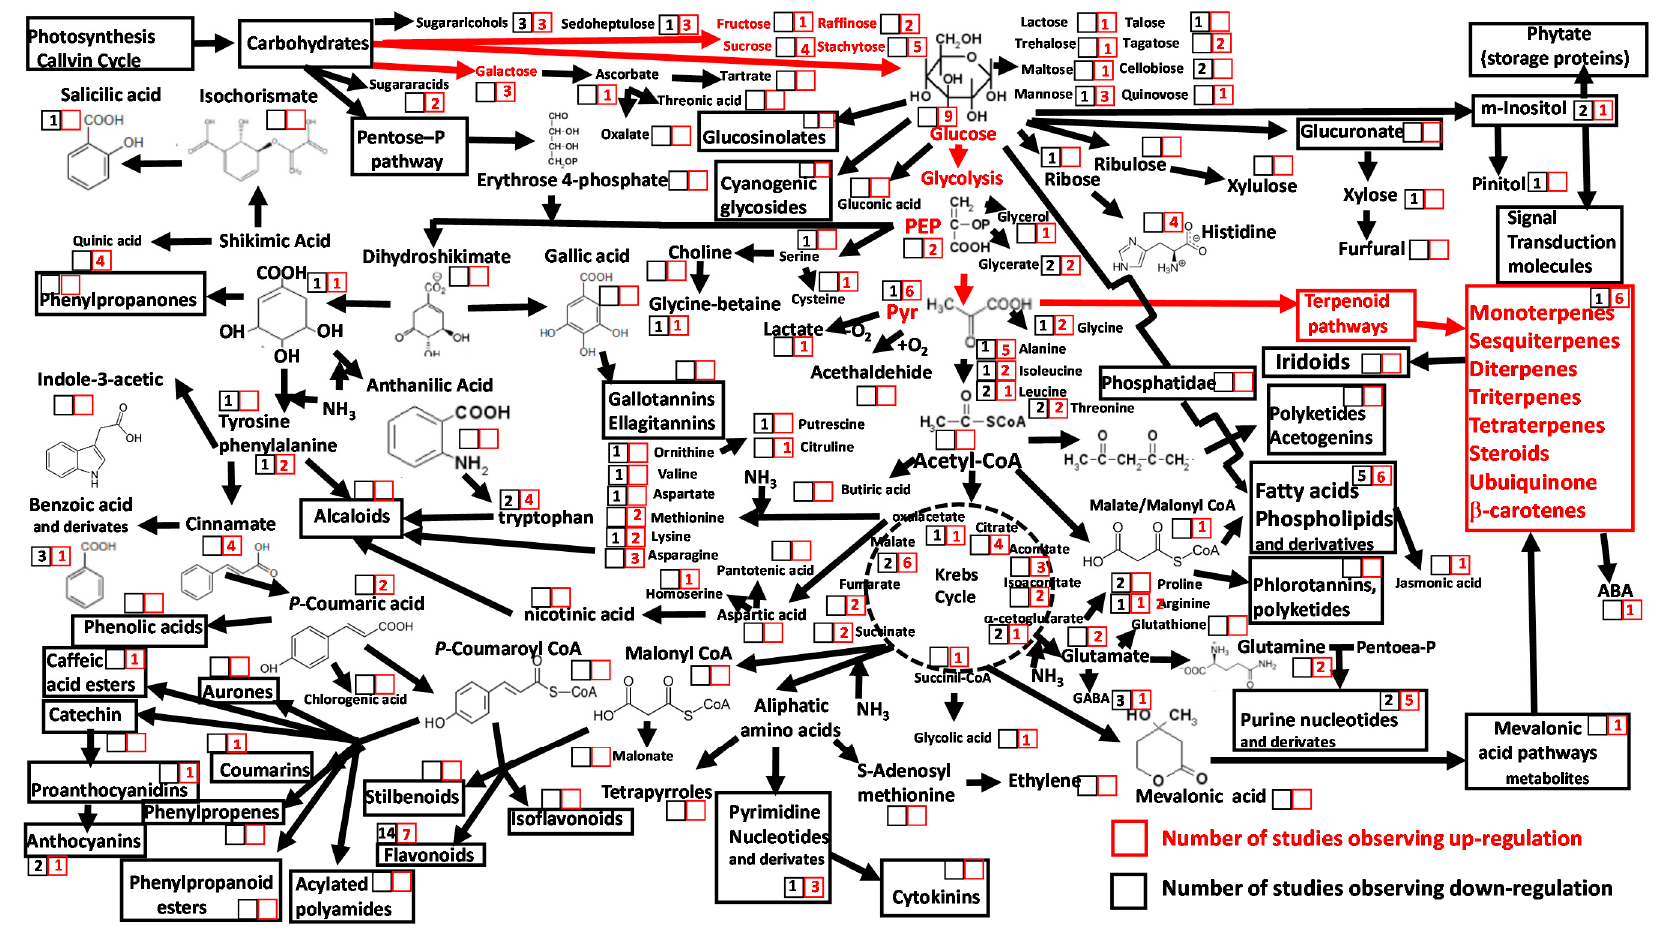
Figure 3. Shifts in principal plant metabolites and metabolic pathways in response to increased atmospheric CO 2 concentrations reported in 17 ecometabolomic studies. The numbers within the squares are the numbers of reports describing changes in photosynthetic tissue metabolite concentration and / or pathway activity under elevated atmospheric CO 2 concentrations. Red numbers within red squares indicate significant increases; black numbers within black squares indicate significant decreases. Red arrows indicate upregulation of the metabolic pathway.